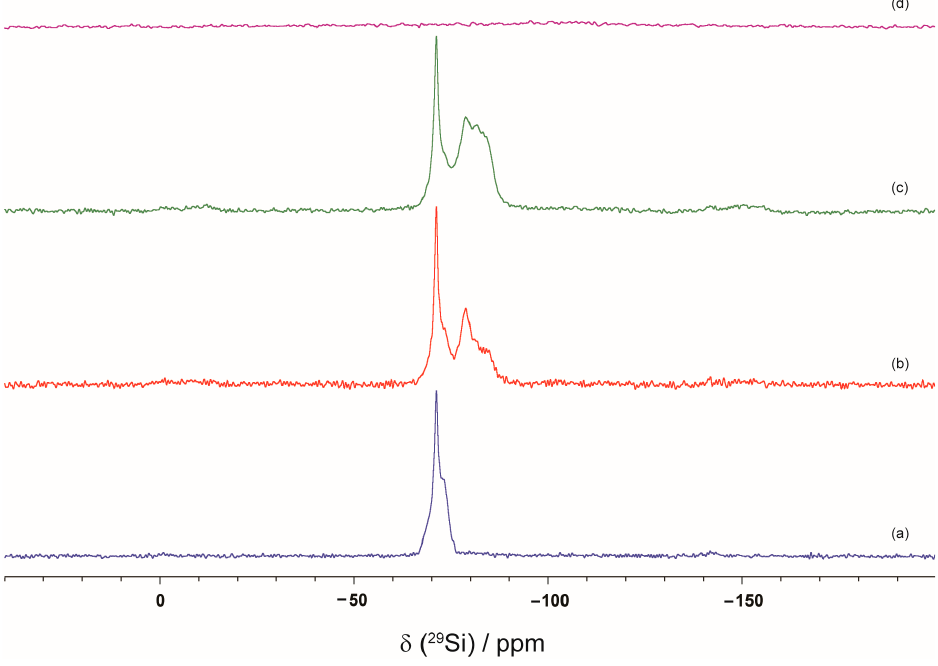
Figure 11. 29 Si MAS NMR spectra of ( a ) CEM, ( b ) CP, ( c ) CP10VSW and ( d ) VSW samples. The 29 Si MAS NMR spectra recorded for the CEM sample show a broad spectral line between the − 66 to − 77 ppm attributed to the alite (C 3 S) and belite (C 2 S) primary phase [41]. VSW does not show any peak in the 29 Si MAS spectra. The different structures of the CSH from CP and CP10VSW are associated with broad spectral lines ranging between − 75 to − 95 ppm and − 66 to − 78 ppm corresponding to the unhydrated clinker (alite and belite) [51,52]. CP and CP10VSW samples contain Si atoms in a tetrahedral environment of oxygen atoms. The spectral line from − 75 to − 90 ppm corresponds with one to two